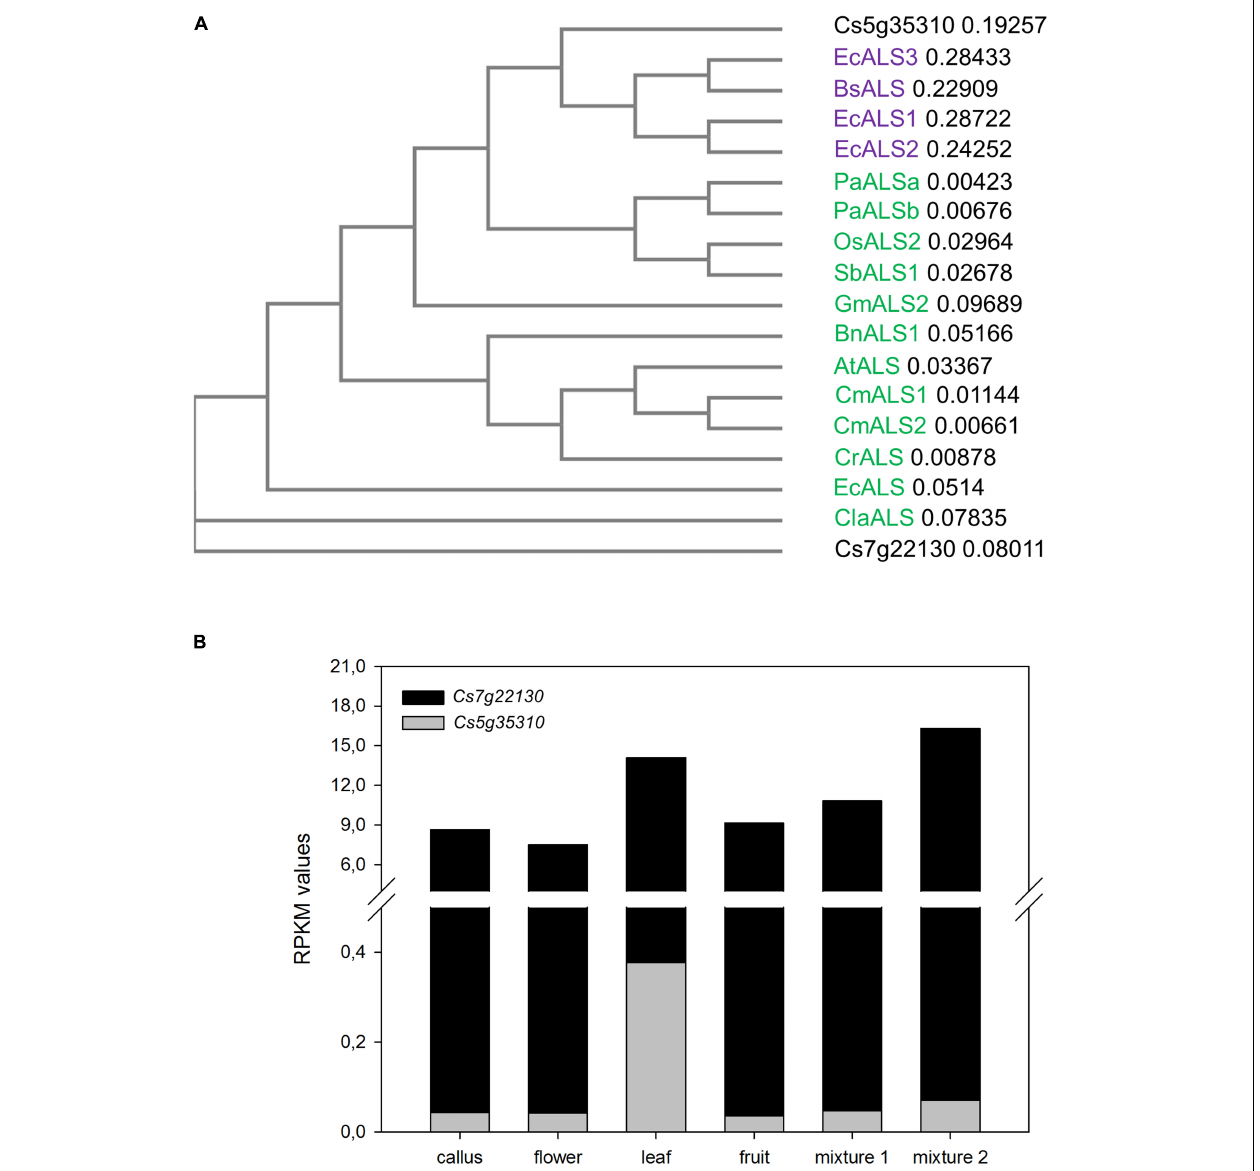
FIGURE 1 | (A) Phylogenetic tree of proteins coded by Cs5g35310 and Cs7g22130 and selected bacterial [ Escherichia coli acetolactate synthase 1 (ALS1), ALS2, and ALS3 (WP_032185508, WP_074505494, and WP_115738825, respectively) and Bacilus subtilis ALS (WP_129110543)] and plant [ Brassica napus (XP_013648961), Camelina microcarpa ALS1(AAR07632) and ALS2 (AAR06607), Arabidopsis thaliana (AAK68759), Capsella rubella (XP_006293107), Erigeron canadensis ALS (AEE68995), Glycine max ALS2 (XP_003545907), Oryza sativa ALS2 (NP_001142174), Sorghum bicolor ALS1(XP_021315526), Poa annua ALSa (ALE27652) and ALSb (ALE27653) and Citrullus lanatus ALS (Cla019277)] ALS enzymes. Bacterial and plant enzymes are purple and green lettered, respectively, while predicted citrus ALS enzymes are written in black. (B) Reads per kilobase per million mapped reads (RPKM) values in leaf, flower, fruit, and three different mixtures of tissues for Cs5g35310 and Cs7g22130 , according to RNA-seq data from Citrus Annotation Project database (CAP; see text footnote 1).